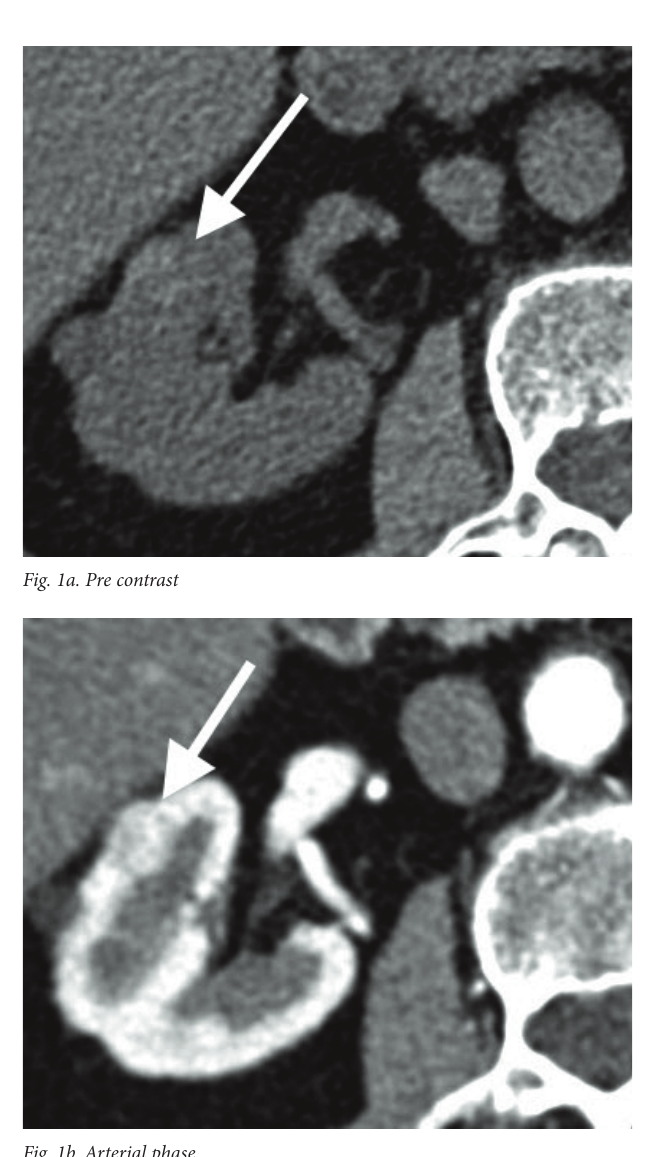
Fig. 1d. Delay excretory